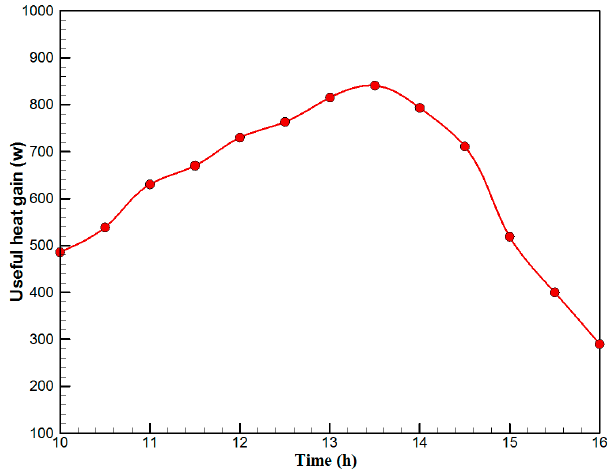
Figure 14. The hourly variation of useful heat gain for the PVT solar collector with CPC.